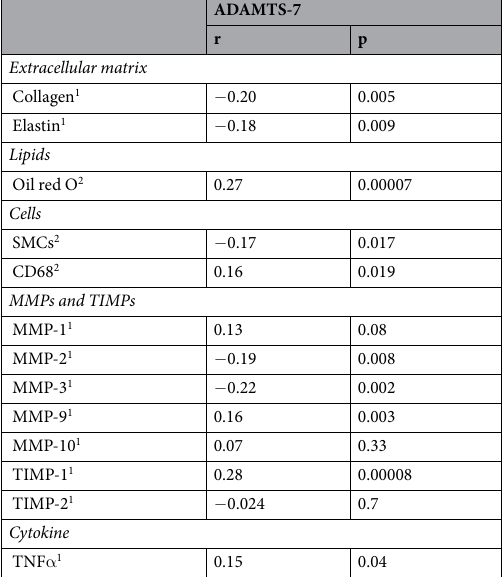
Table 2. Correlation of ADAMTS-7 (% of plaque area stained) in lesions to extracellular matrix, lipids, cells and MMPs. 1 Weight per gram plaque tissue. 2 Percentage of plaque area